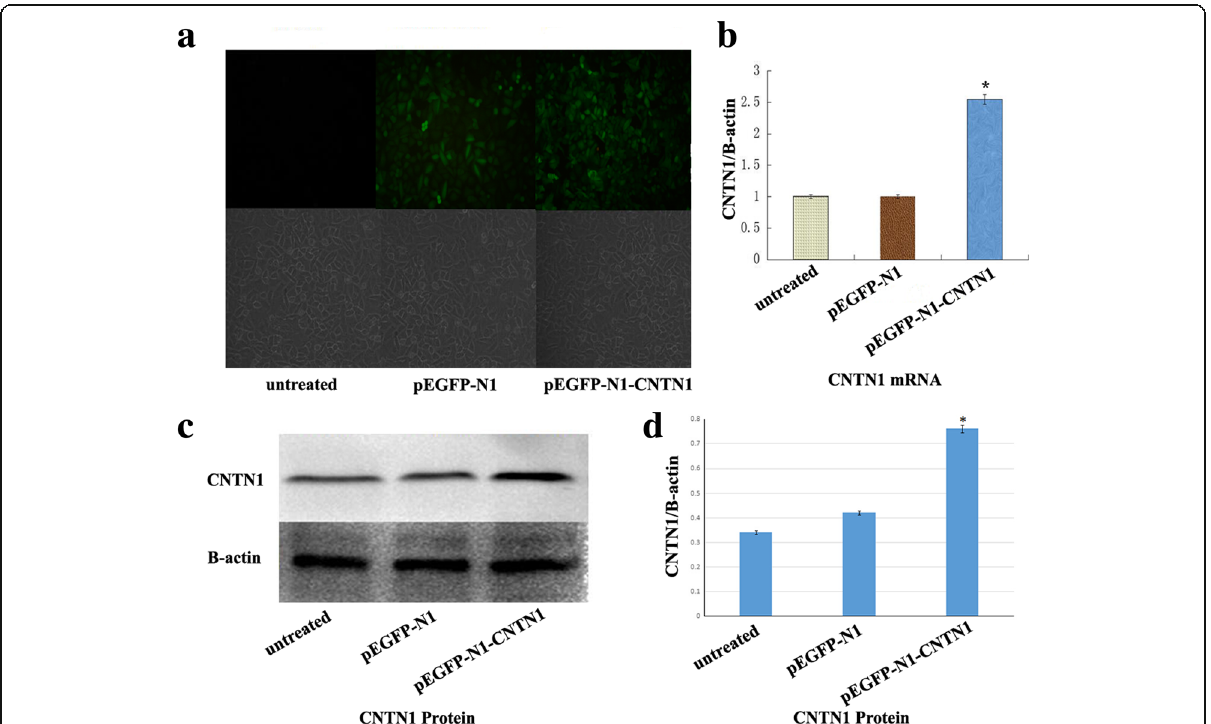
Fig. 2 Expression of CNTN1 in Hs578T cells. a Immunocytochemical staining 48 h after transfection, b Real-time RT-PCR: Expression of CNTN1 was significantly increased in CNTN1-transfected cells ( P <0.05). c Western blot. CNTN1 was overexpressed compared with controls ( P <0.05), d Western blotting quantitation